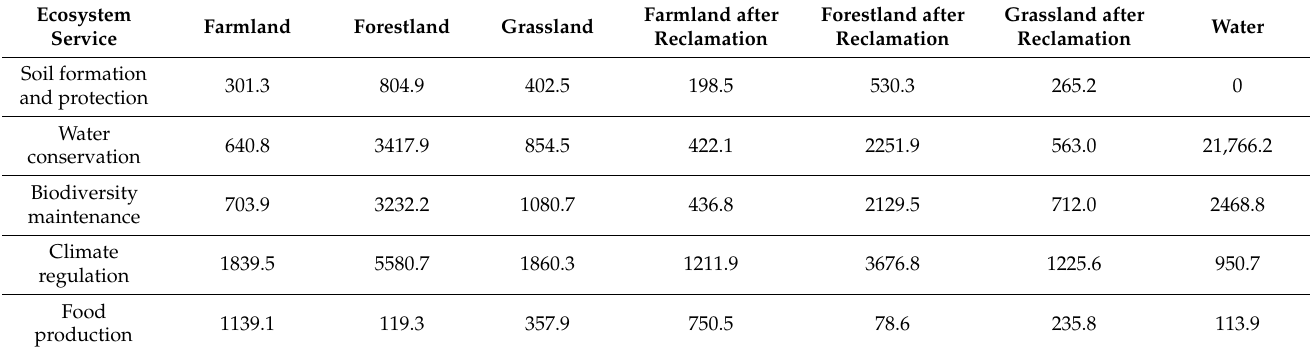
Table 1. Ecosystem service value of land use types per unit area in Pingshuo mining area (RMB/hm 2